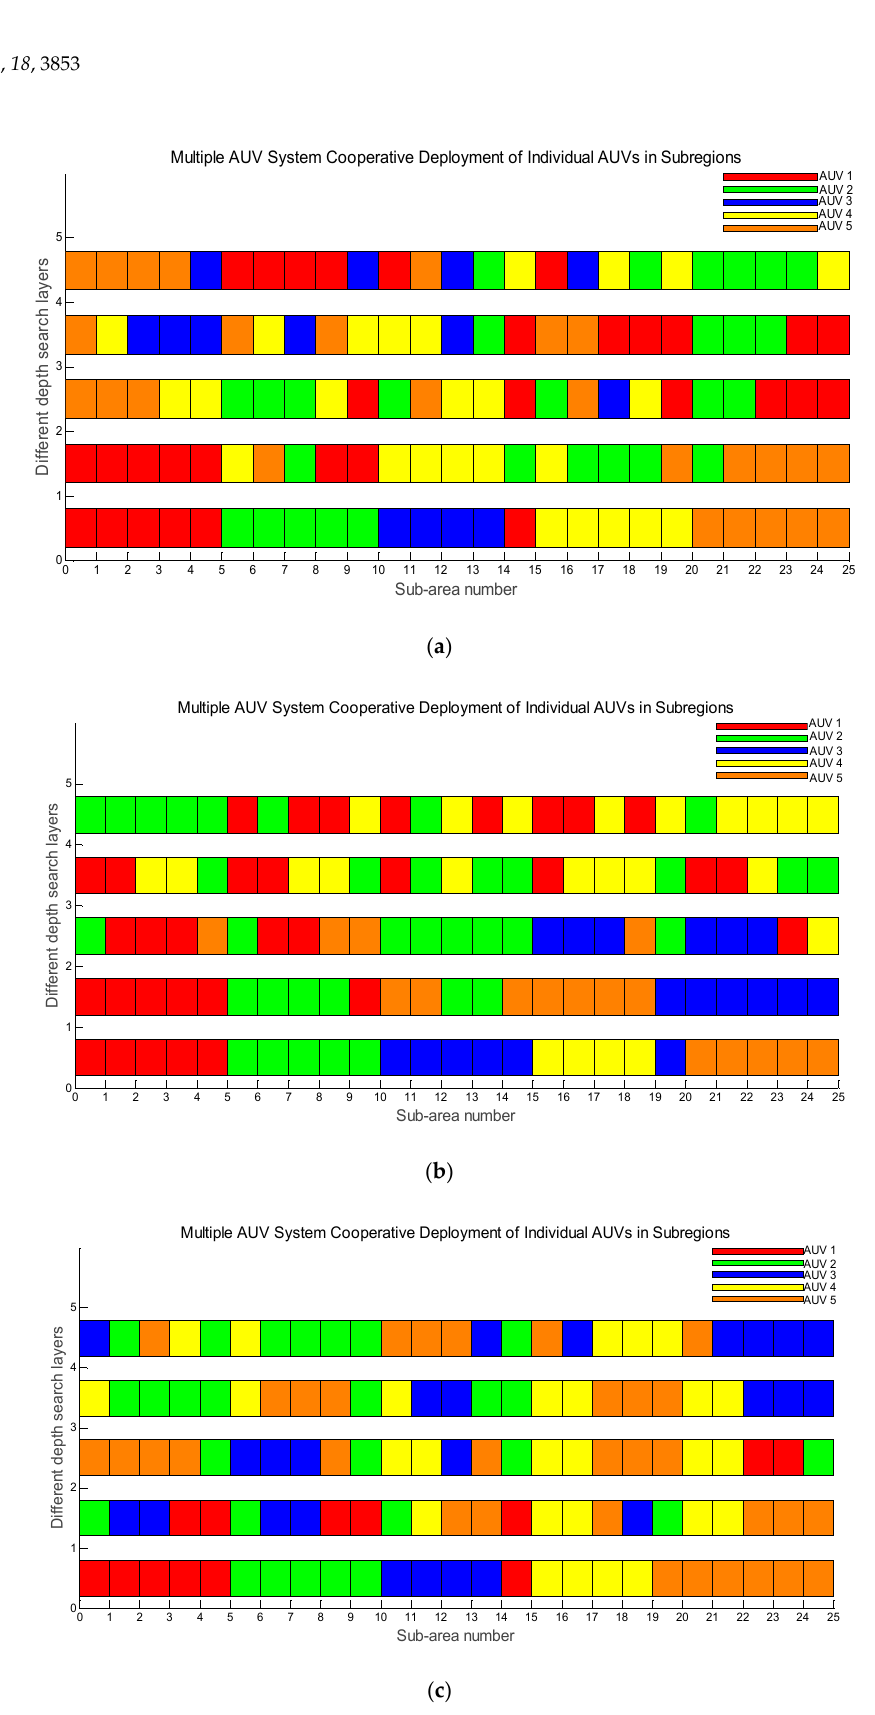
Figure 10. Self-adaptive allocation of individual AUVs among sub-regions in a multi-AUV system under an adaptive predictive search algorithm. ( a ) Collaborative deployment scheme under static targets. ( b ) Collaborative deployment scheme under dynamic targets. ( c ) Collaborative deployment scheme under faulty AUVs.